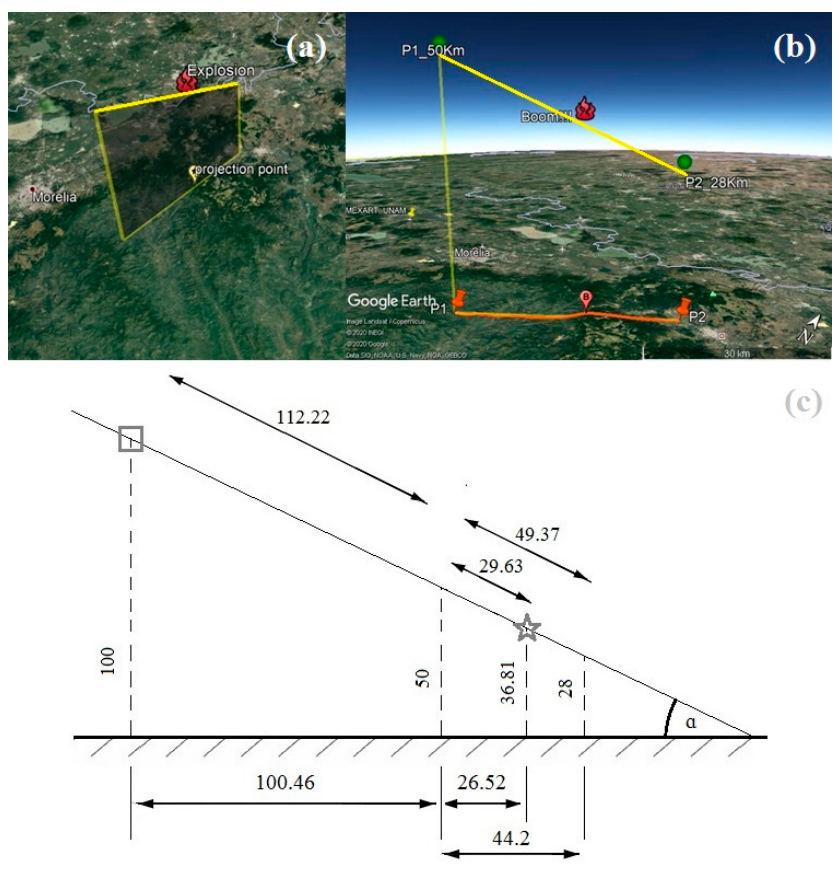
Figure 4. ( a , b ) Illustration by Google Earth; ( c ) scheme of calculated meteoroid/meteor trajectory and its projection on the ground (approximate distances are indicated in km).